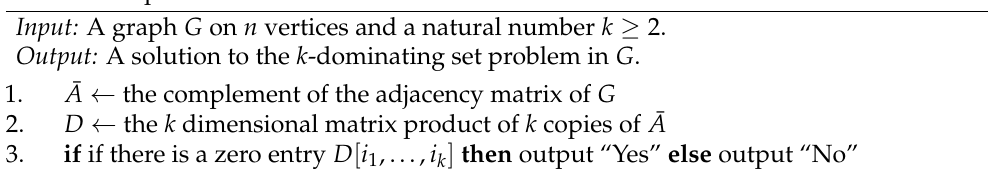
Algorithm 3 Improved straightforward enumeration algorithm by using fast rectangular matrix multiplication.